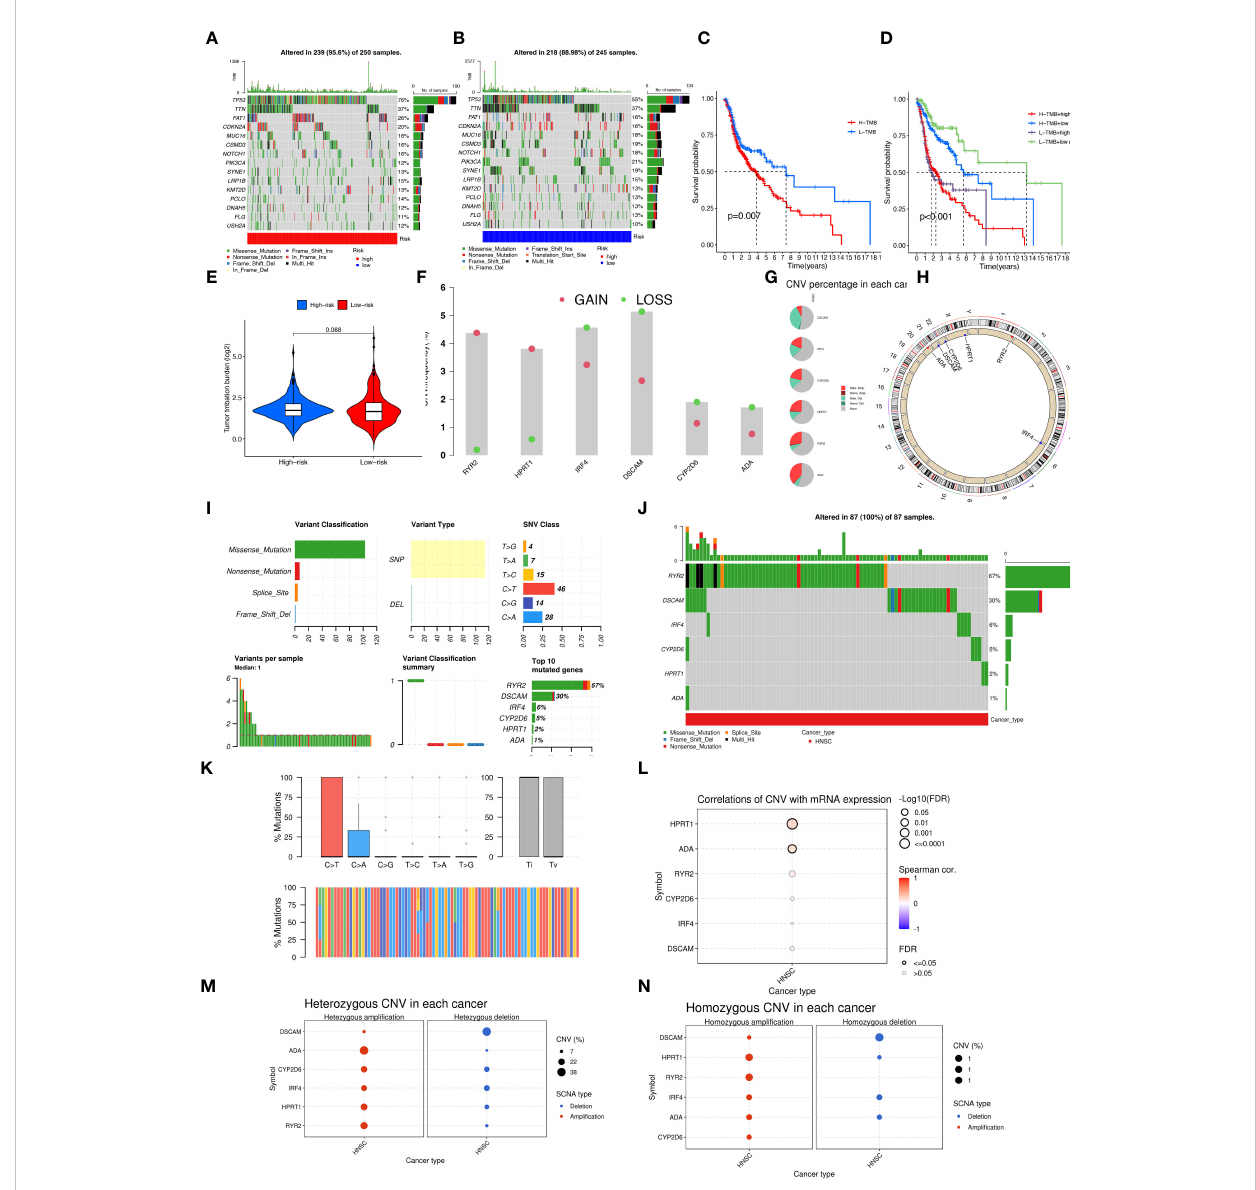
FIGURE 8 Multi-omics mutation analysis of 6-CRRGs. (A) Somatic mutations in the high-risk group. (B) Somatic mutations in the low risk group. (C) The KM curve compares the overall HNSCC patients between high and low mutation groups. (D) KM curve based on mutation and risk scores for the four subgroups compares the overall HNSCC patients between. (E) TMB analysis between high- and low-risk groups. (F) Copy number trends of 6-CRRGs. (G) CNV occupancy. (H) Copy number change circle plot. (I) Mutations of 6-CRRGs in TCGA-HNSCC patients. (J) Mutation analysis of 6-CRRGs in somatic cells. (K) SNV analysis. (L) Copy number variation and gene expression Spearman correlation coef fi cient analysis. (M) Heterozygous mutations. (N) Homozygous